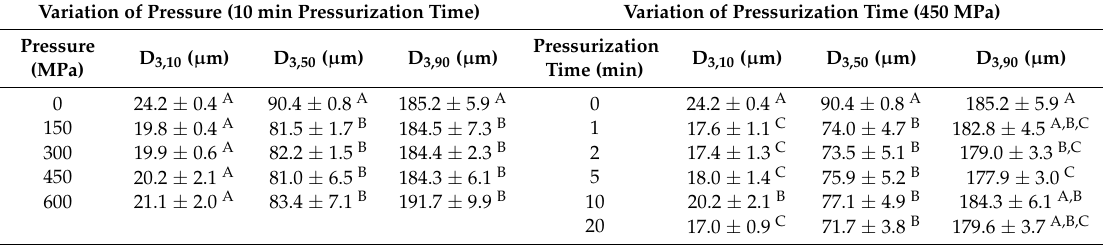
Table 3. Granular alterations of wheat flour particles determined by the particle size distribution (volume) in dependency of pressurization time and pressure, x ± SD, n = 3. Variation of Pressure (10 min Pressurization Time) Variation of Pressurization Time (450